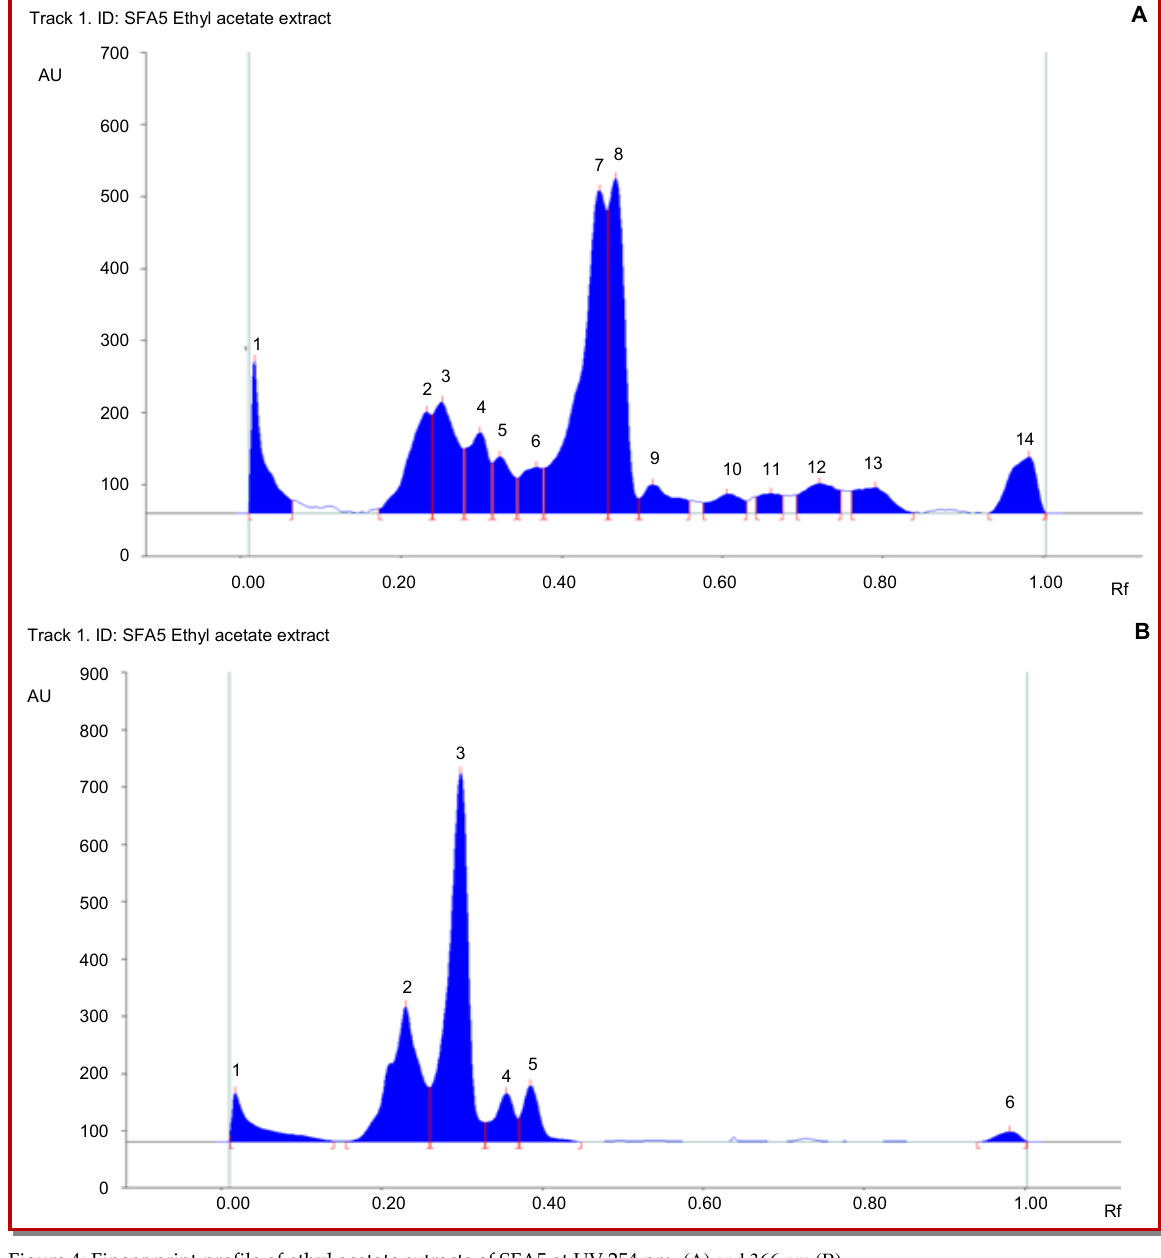
Figure 4: Finger print profile of ethyl acetate extracts of SFA5 at UV 254 nm (A) and 366 nm (B)